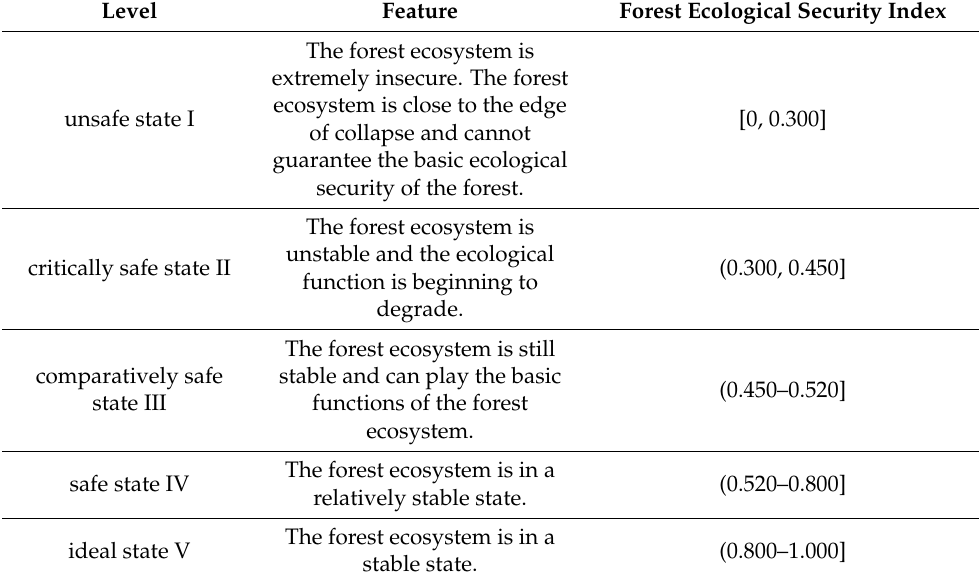
Table 2. The classification standards of FES